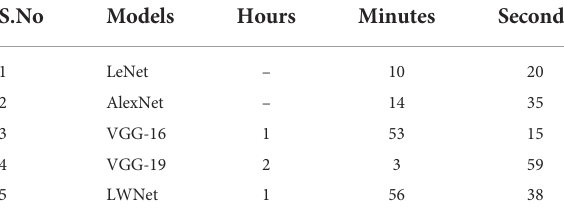
TABLE 9 Simulation time of Model